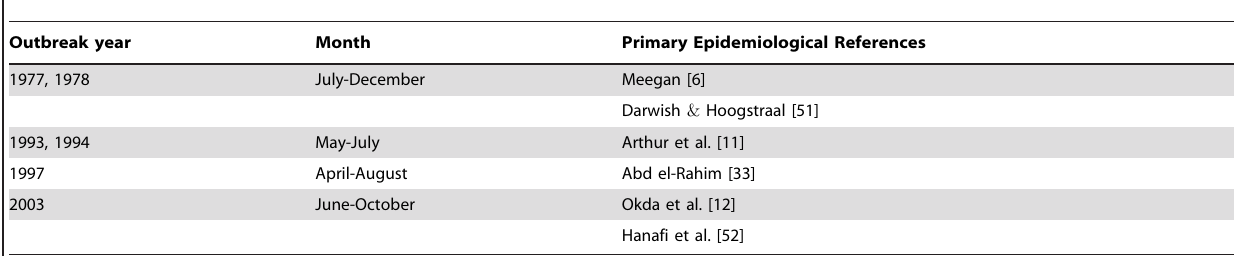
Table 1. Summary of outbreaks of Rift Valley fever in Egypt, 1977–2011